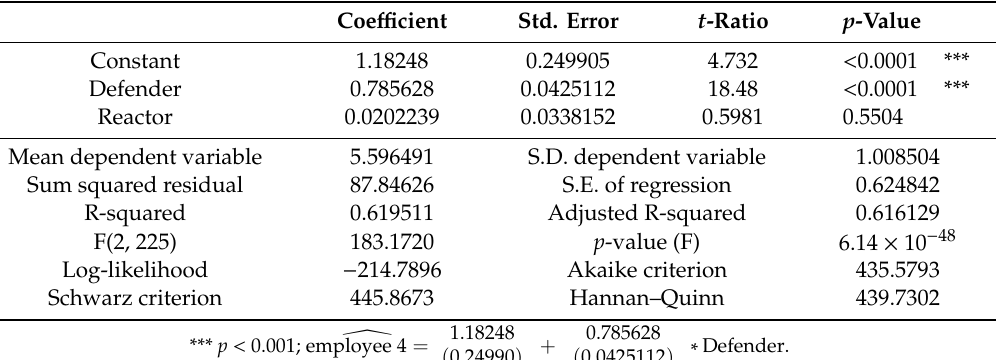
Table 12. Model 12: OLS, using observations 1–228. Dependent variable: Employee